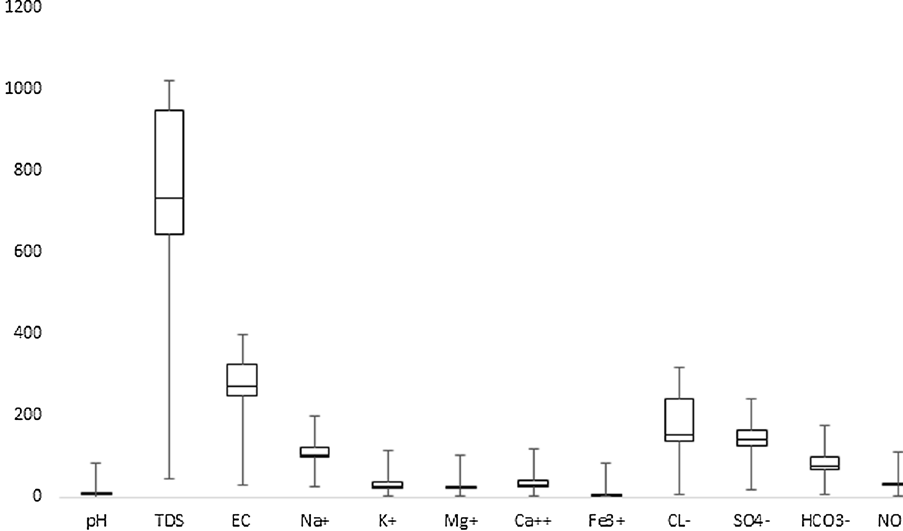
Fig. 8 Boxplot for physiochemical parameters for hand-dug